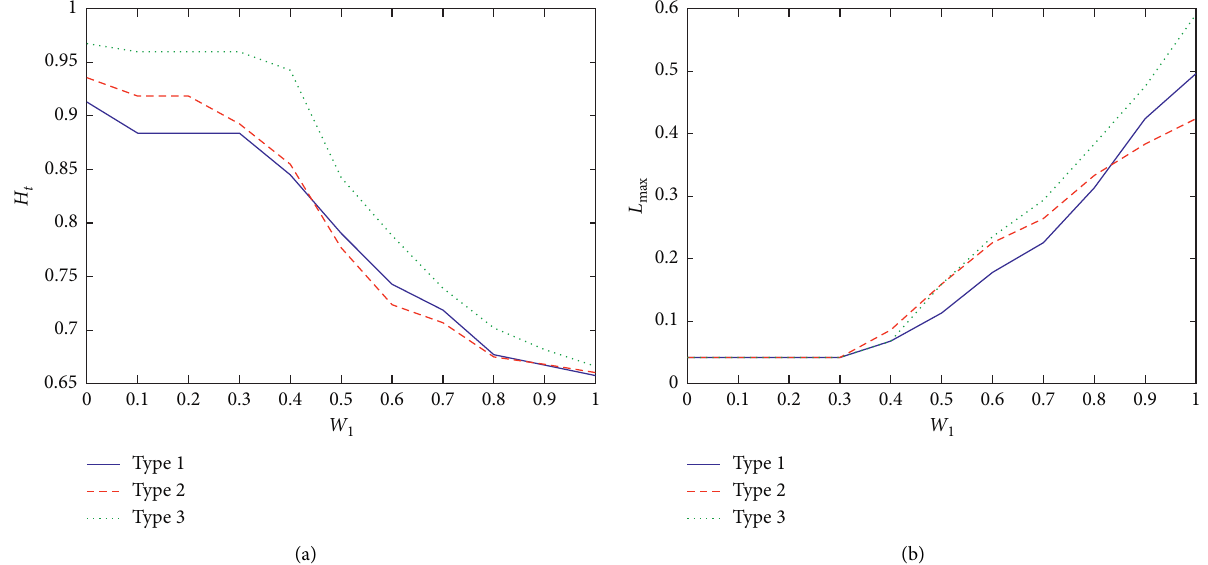
Figure 7: (a) The normalized total number of hops versus w ; (b) L